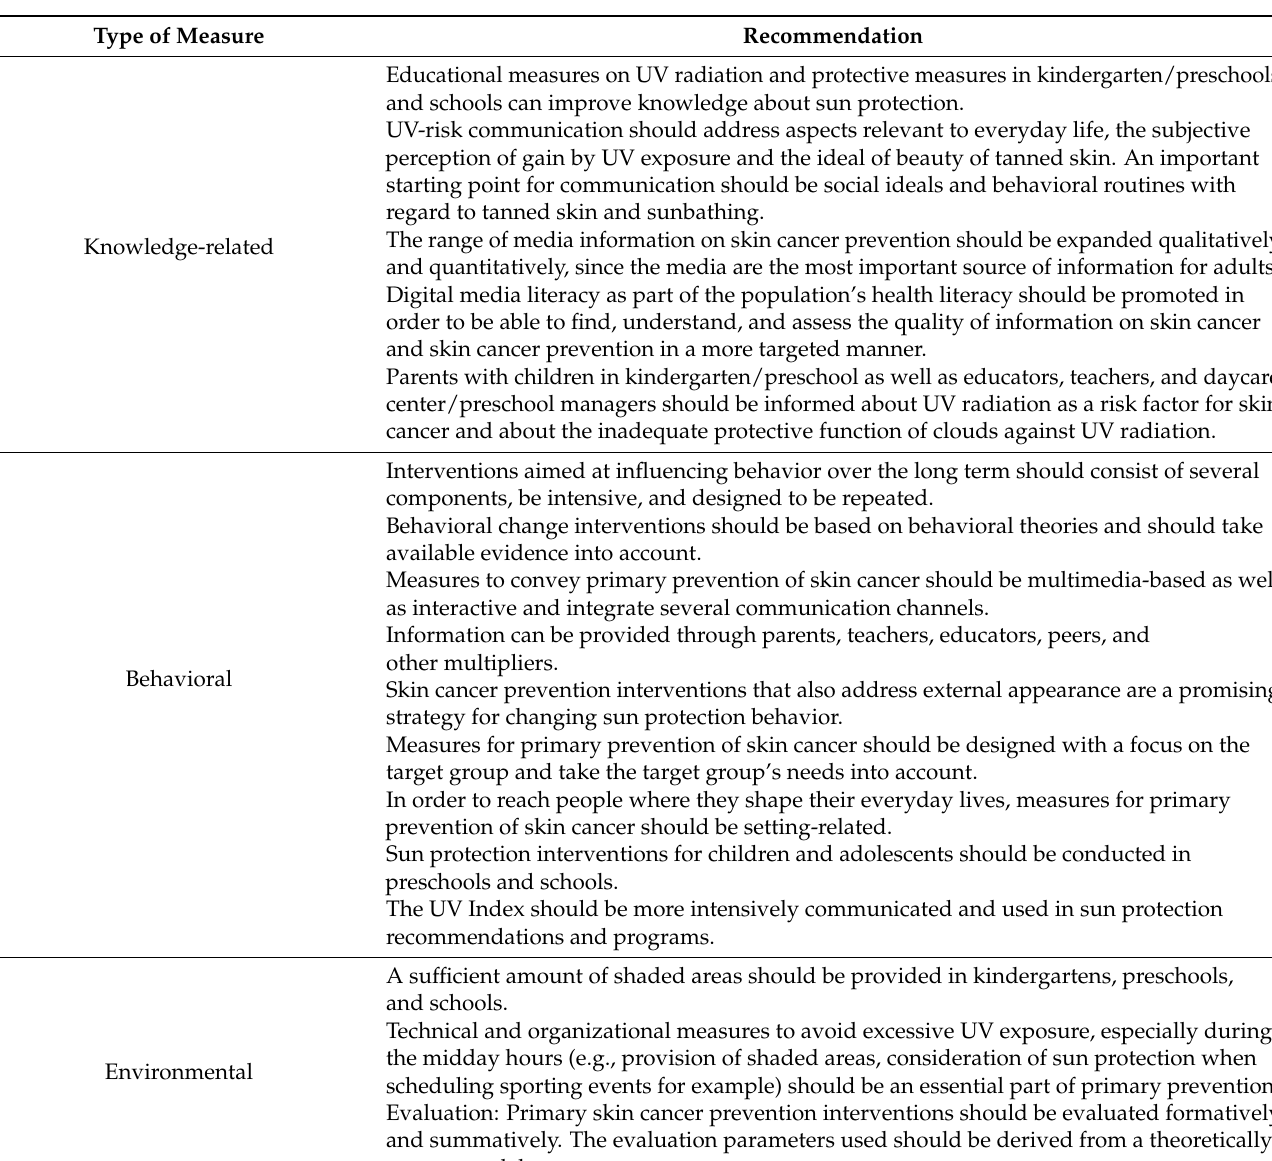
Table 1. Recommendations for measures promoting primary skin cancer prevention, according to the German guideline on skin cancer prevention